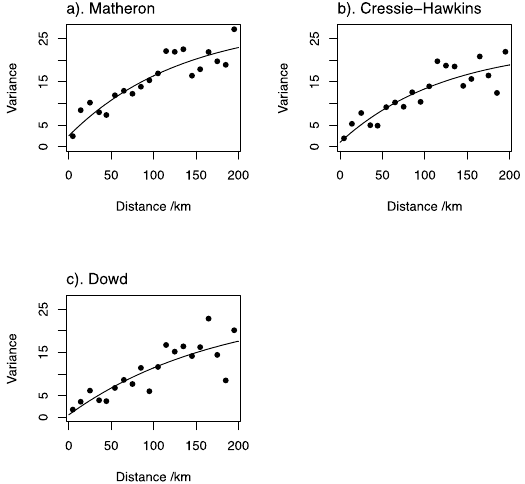
Figure 3. Variograms of serum Se concentration in women of reproductive age (WRA) in Ethiopia estimated by different estimators; ( a ) Matheron, ( b ) Cressie-Hawkins and ( c ) Dowd.